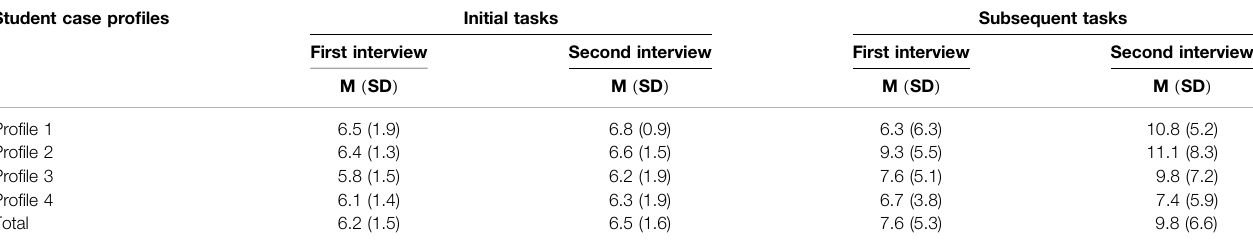
TABLE 3 | Descriptivestatistics for selection of tasks: Mean values (M) and standard deviation (SD) ofnumber of selected tasks, differed by initial and subsequent tasks and student case pro fi les. Student case pro fi